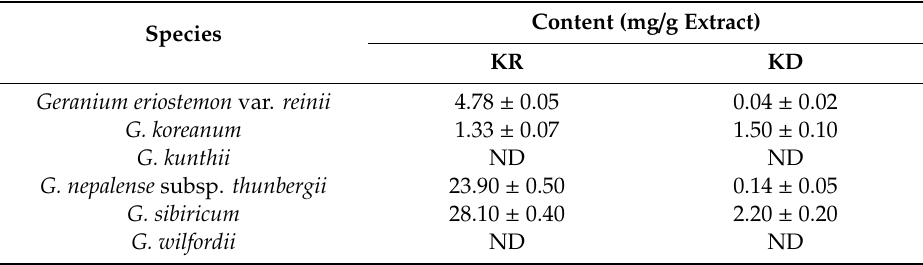
Table 6. Amount of KR and KD in the MeOH extract of Geranium species.